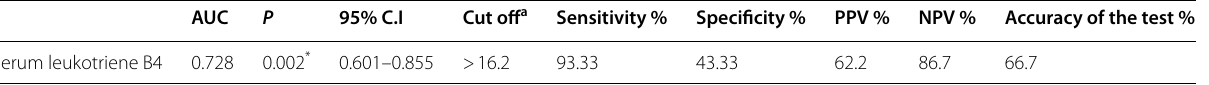
Table 2 Agreement (sensitivity, specificity) for LTB4 to diagnose decompensated cirrhosis group ( n group ( n =